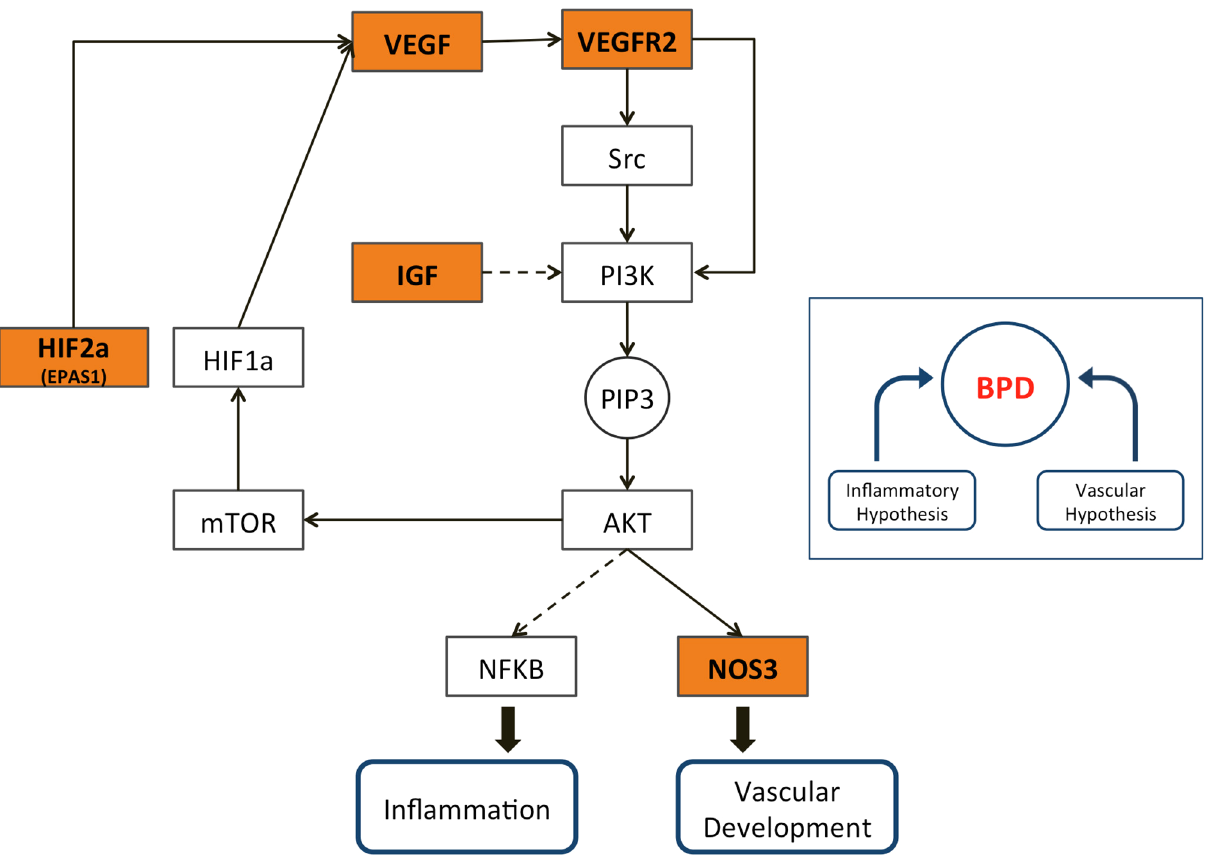
Figure 6. The VEGF pathway and its relevance to both BPD hypotheses. The relationships shown here are derived from the VEGF, PI3K-AKT, mTOR, and HIF-1 signaling pathways and the ‘‘Pathways in Cancer’’ map in the KEGG Pathway database. Dashed lines represent indirect regulation. Genes highlighted in orange are the five lung development genes implicated in ROP.